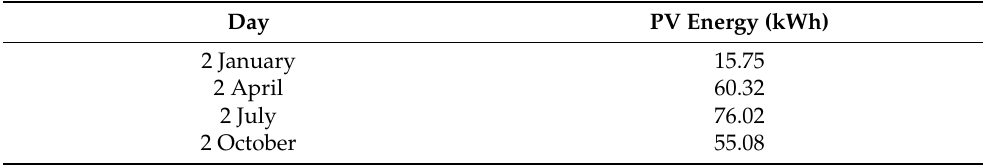
Figure 5. Daily power and monthly energy generated by the (12 kWp) photovoltaic array. Table 3. Daily energy generated by the PV array for the selected